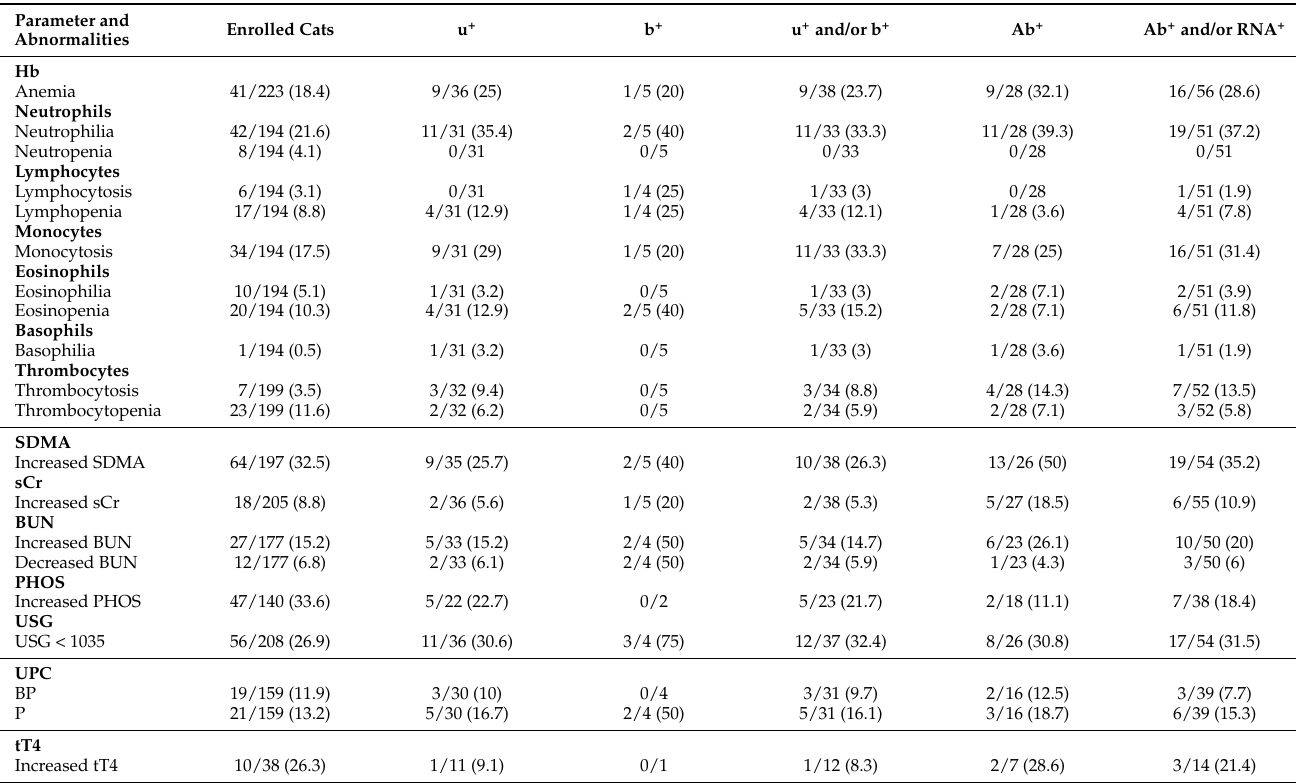
Table 4. Prevalence (%) of complete blood count and renal profile abnormalities in enrolled cats and in cats positive to FeMV according to their positivity with qPCR FeMV from urine (u + ), blood (b + ), urine and/or blood (u + and/or b + ), FeMV Abs (Ab + ), FeMV Abs and/or qPCR FeMV (Ab + and/or RNA + ). Hb = hemoglobin; SDMA = symmetric dimethylarginine; sCr = serum creatinine; BUN = blood urea nitrogen; PHOS = phosphorus; USG = urine specific gravity; UPC = urine protein to creatinine ratio; tT4 = total thyroxine; BP = borderline proteinuric; P =